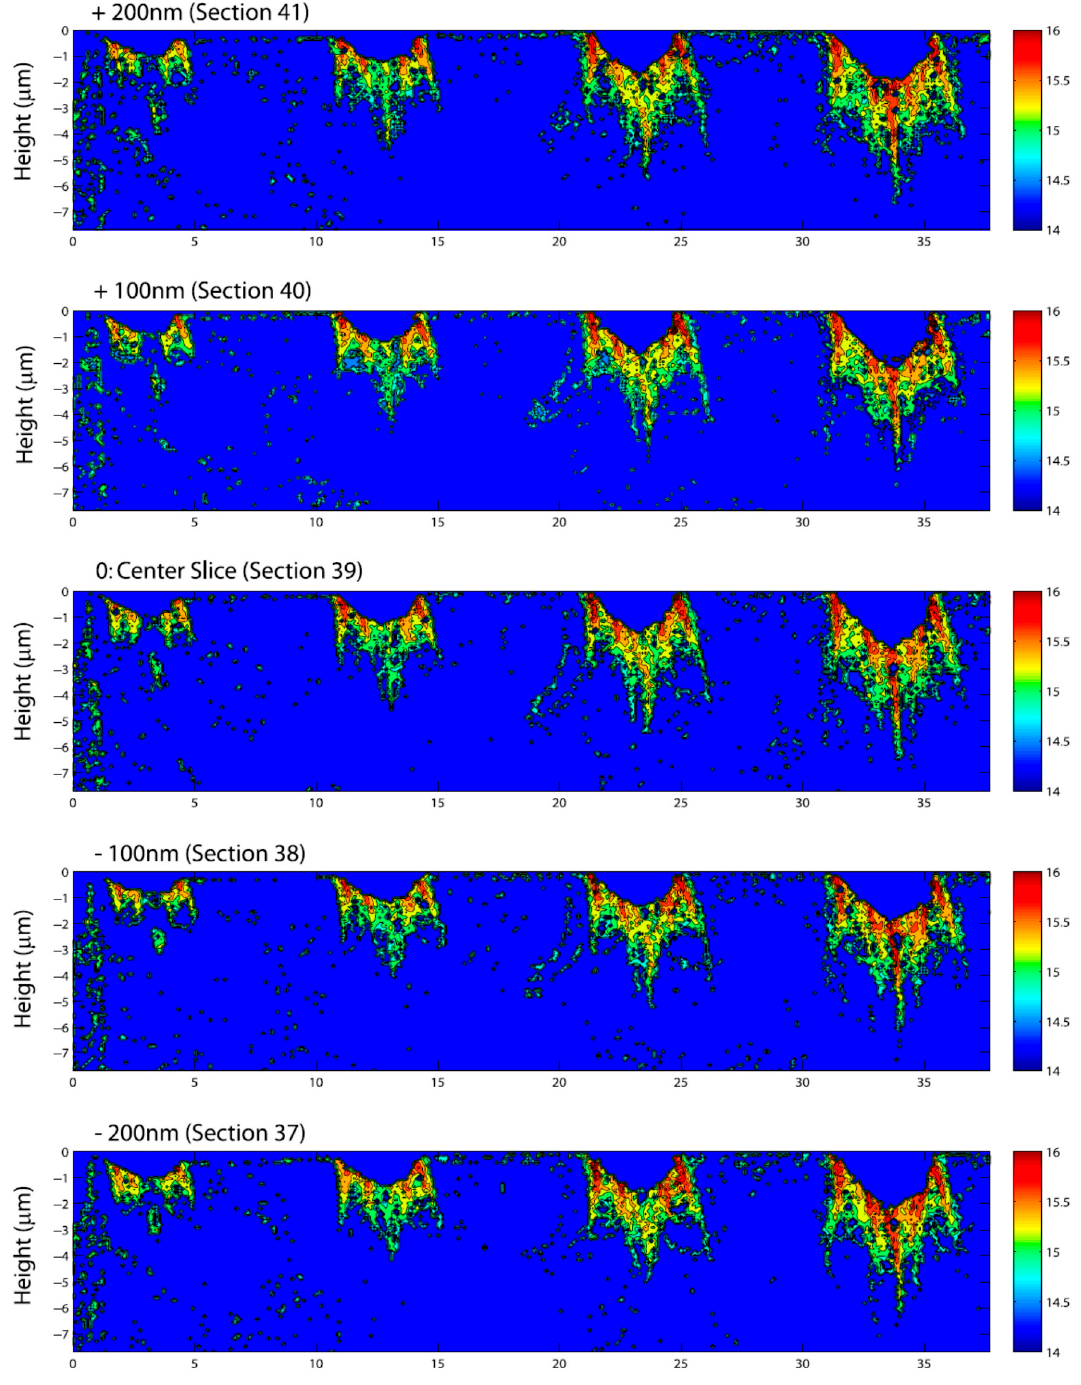
Figure 14. Five equally-spaced cross-sections (center slice, ±100 nm, ±200 nm) through the four indents. Color code: GND density in decadic logarithmic scale (m − 2 ) (after Demir et al. [121]).